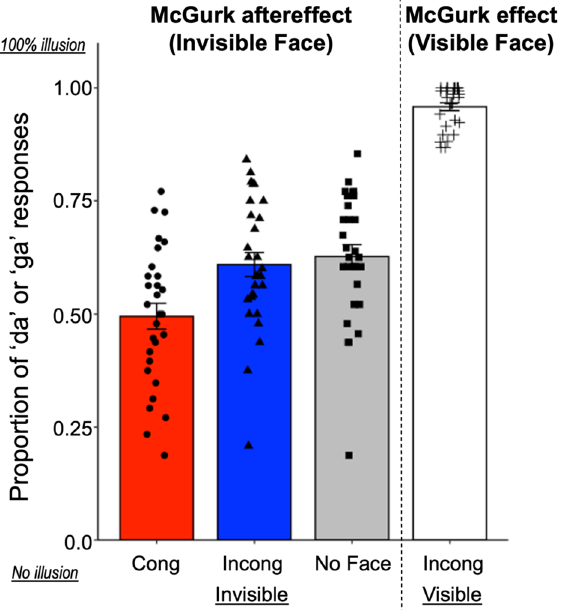
Figure 2. Proportion of ‘da’ or ‘ga’ response (illusory percepts) in Experiment 1. The rightmost bar (Incong Visible) represents the proportion in the McGurk induction phase. Black circles, triangles, squares, and crosses represent individual data. Error bars denotes the standard error of the mean. Plots were generated using R software version 4.0.5 (R Core Team (2021). R: A language and environment for statistical computing.